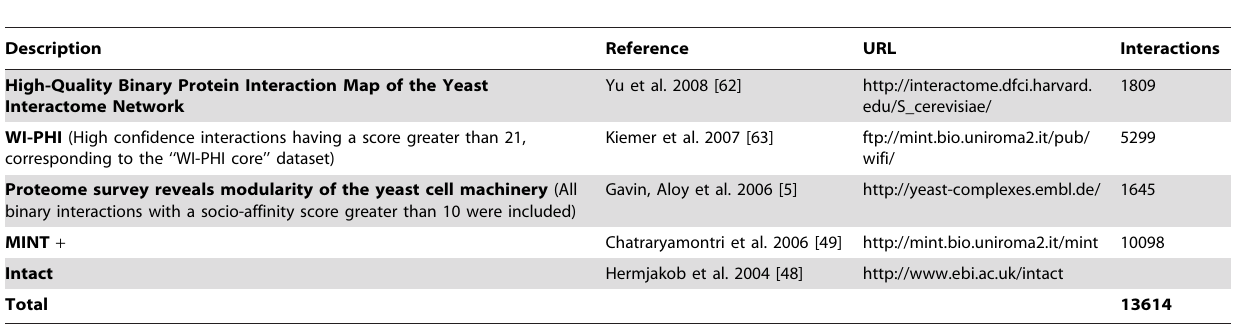
Table 2. Sources of experimentally identified protein-protein interactions in yeast.